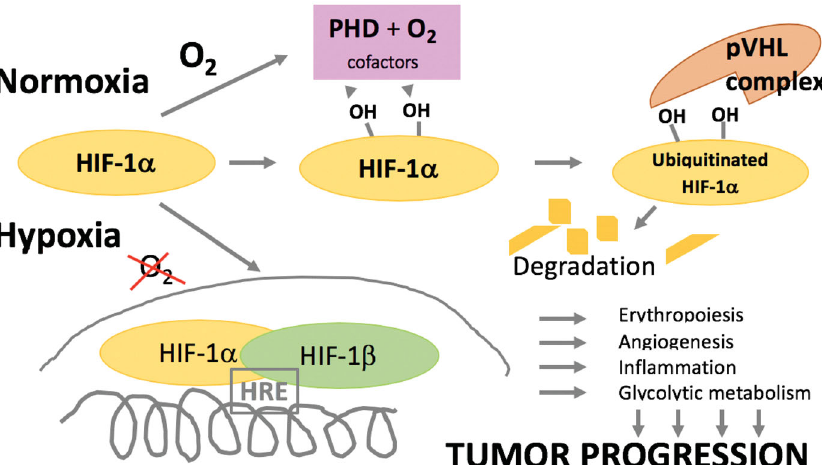
Figure 1. Simplified schematics of oxygen sensing and transcriptional regulation. In normoxia the hypoxia-inducible factor (HIF)-1 a subunit becomes hydroxylated on several residues by prolyl hydroxylase (PHD), which uses molecular oxygen as a substrate. Hydroxylated HIF-1 a is recognised by the von Hippel Lindau (pVHL) complex which catalyses its ubiquitination and degradation. In hypoxia, HIF-1 a remains stable and translocates to the nucleus to form a complex with the HIF-1 b subunit to become a transcriptionally active complex, binding to the hypoxia-responsive element (HRE). Genes are induced that regulate a wide range of processes exploited to serve the progression of